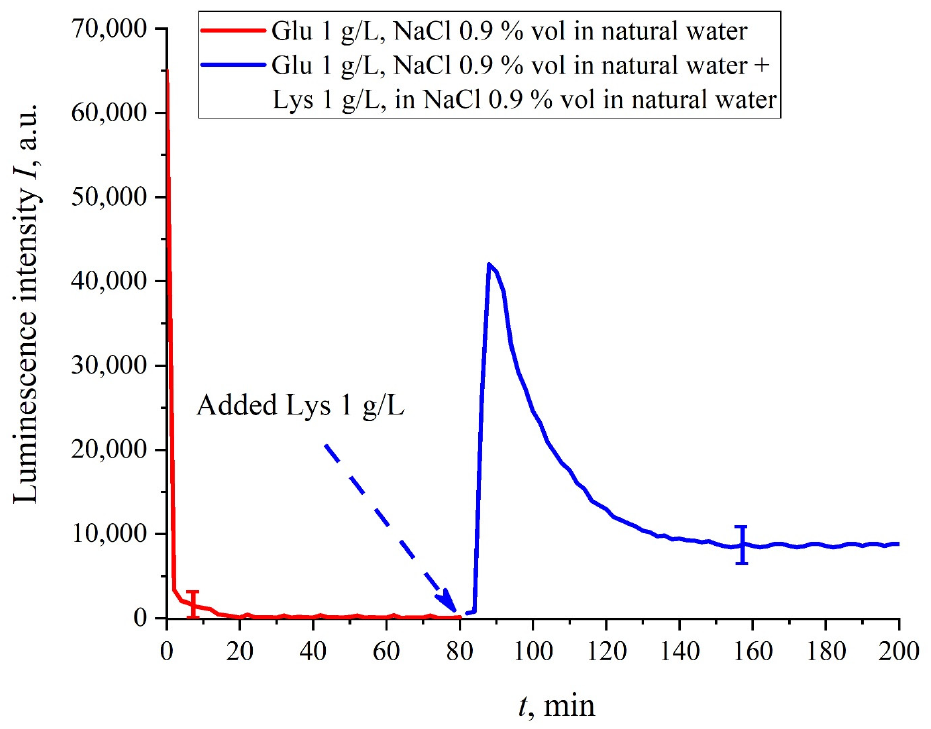
Figure 7. Dependence I ( t ) vs. the soaking time in an ordinary water-based saline solution (0.9 vol.% NaCl) at adding a lysine suspension (1 g/L), prepared in an ordinary water-based saline solution. The adding of lysine suspension occurred at 80-th minute. The volumes V of suspensions of glutamic acid and lysine are the same. The case for DDW-based suspensions is presented in Figure 8a,b. Panel (a) corresponds to the adding a lysine suspension with concentration of 0.1 g/L (50-th minute), and panel (b) is related to the adding a lysine suspension with concentration of